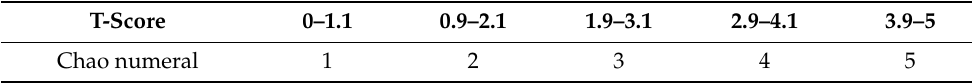
Table 6. T-score and Chao numeral conversion (Liu 2008).